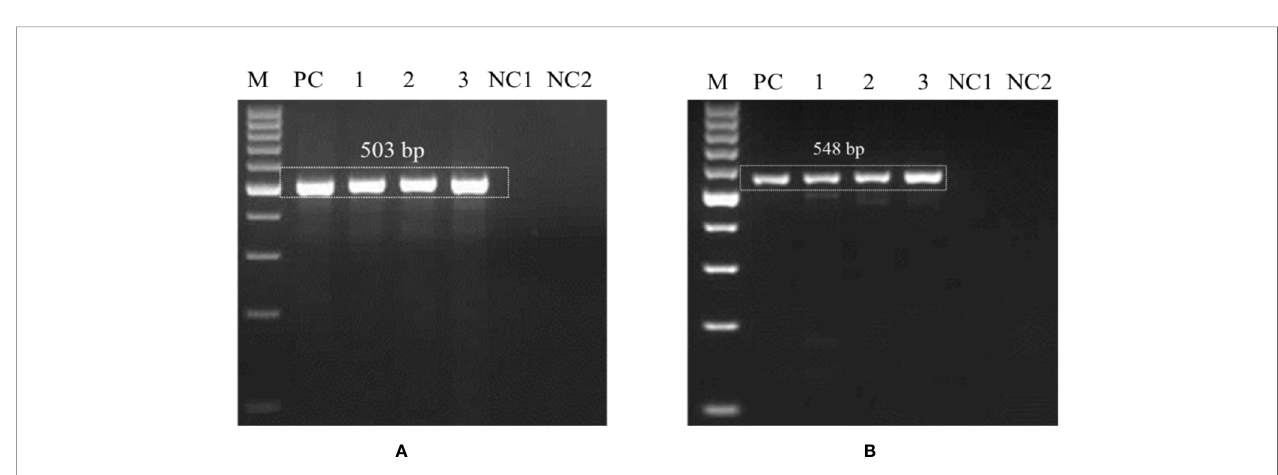
FIGURE 6 | Agarose gel electrophoresis displaying the PCR products ampli fi ed by UA-15F/UA-562R (A) and UA-17F/UA-519R (B) primer sets using fi eld soil DNA derived from U. agropyri infested disease sick plot and sterilized healthy soil without U. agropyri . M, 100 bp DNA marker; PC, PC: Positive control of U. agropyri FLS1 DNA only; NC1, Negative Control where addition of sterile water without DNA template of soil of disease sick plot; NC2, Negative control employing DNA of healthy soil without U. agropyri